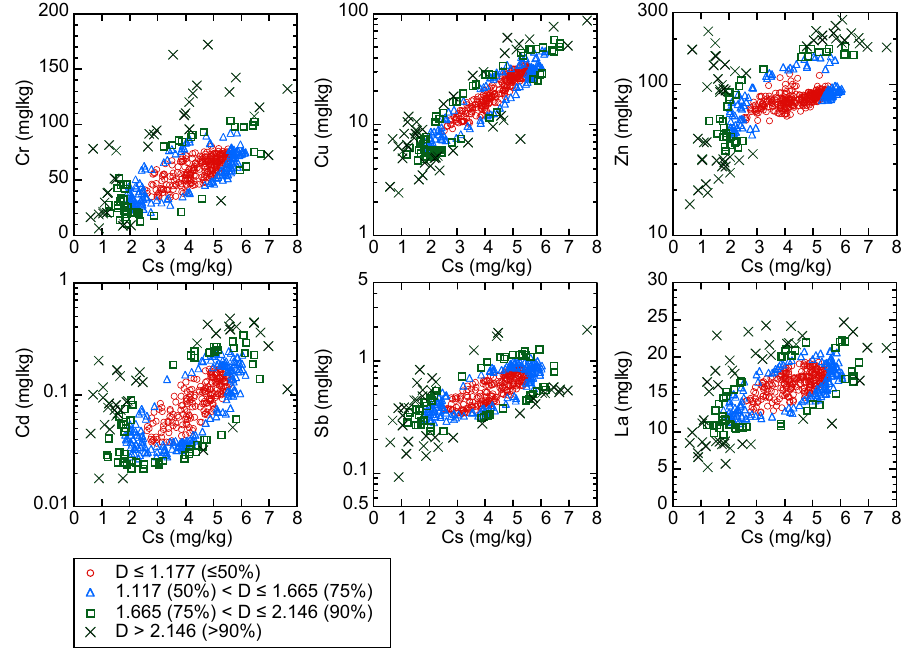
Figure 9. Relationship between elemental concentrations and Cs concentration. Mahalanobis’ generalized distances (D) increase from the central part to the outer part of the plot in an onion-like structure. Values of D ≤ 1.117, D ≤ 1.665, and D ≤ 2.146 indicate that 50%, 75%, and 90% of the total data points are included, respectively.